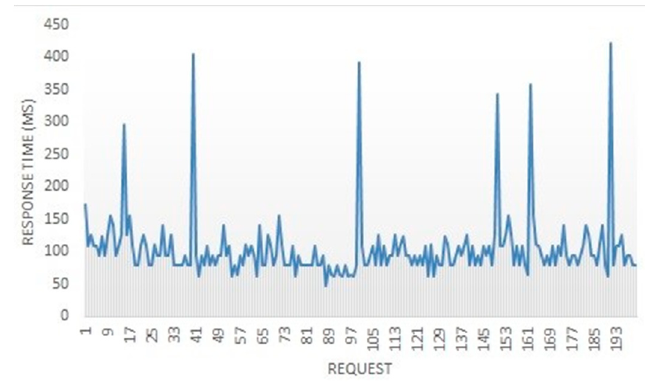
Figure 8. Performance assessment–Response time.